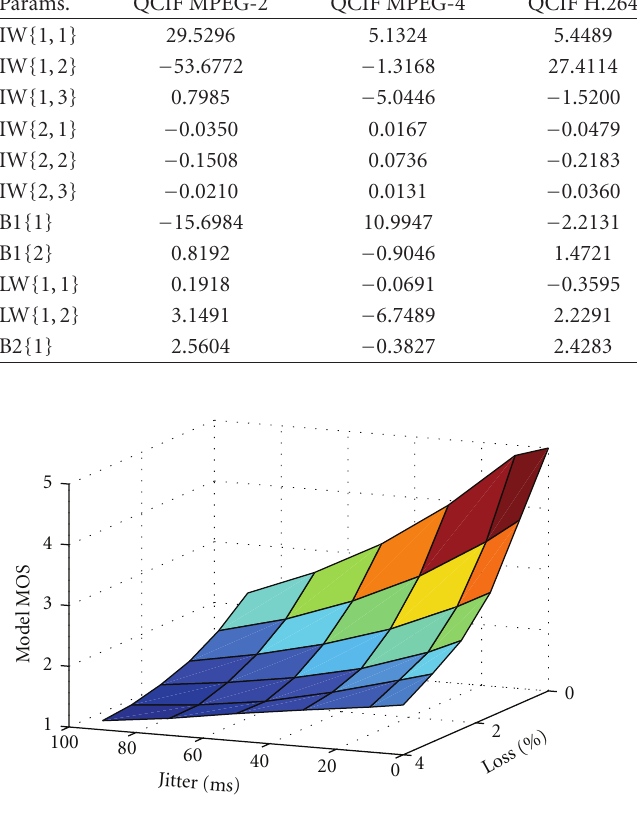
Figure 12: TFIFO HD model characteristics at 512 Kbps bit